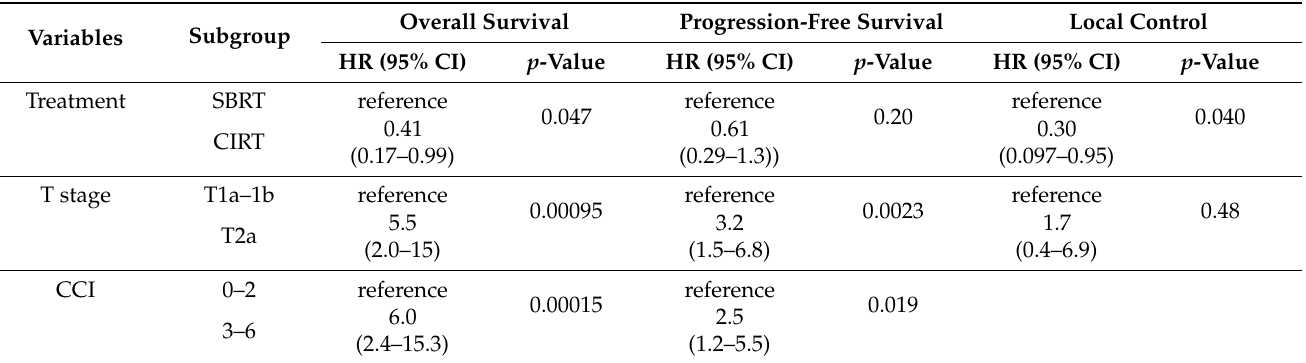
Table 2. Cox regression analysis ( n = 89).